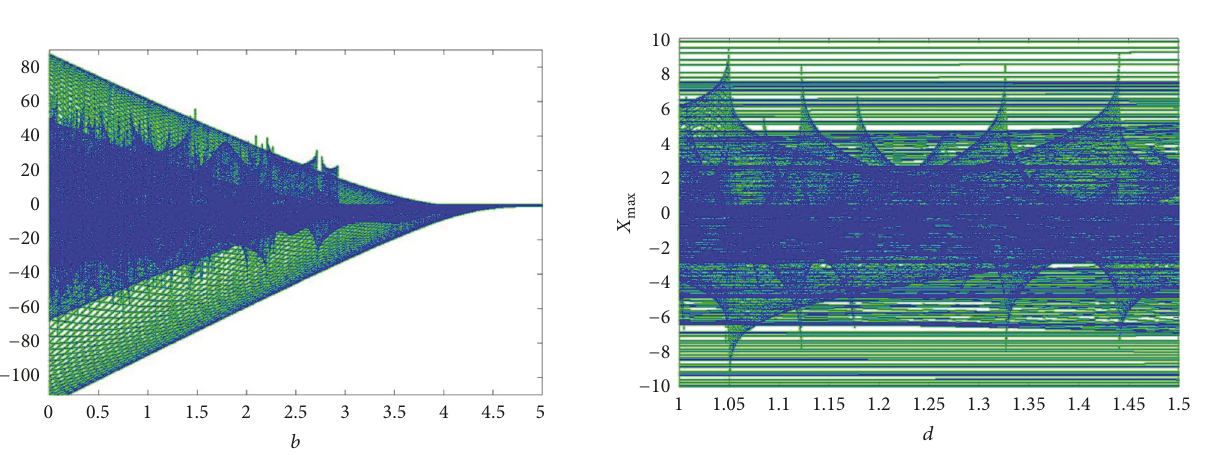
Figure 5: Bifurcation plots for parameter 𝑎 .